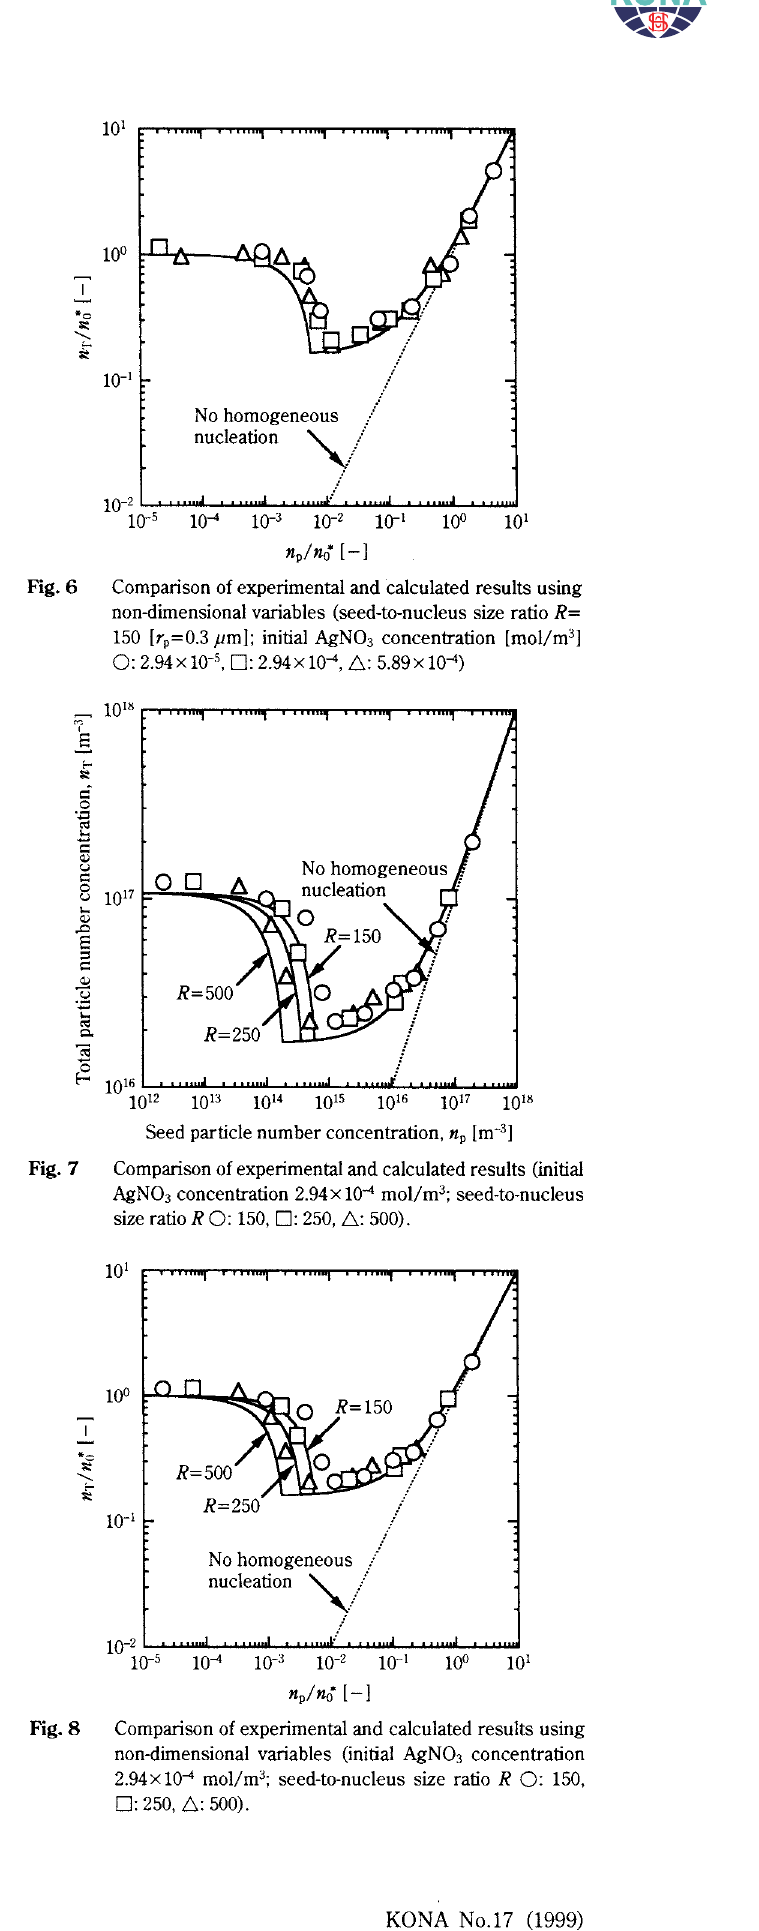
Fig. 8 Comparison of experimental and calculated results using non-dimensional variables (initial AgN0 3 concentration 2.94xl0-4 mol/m 3; seed-to-nucleus size ratio R 0: 150, 0:250, 6: